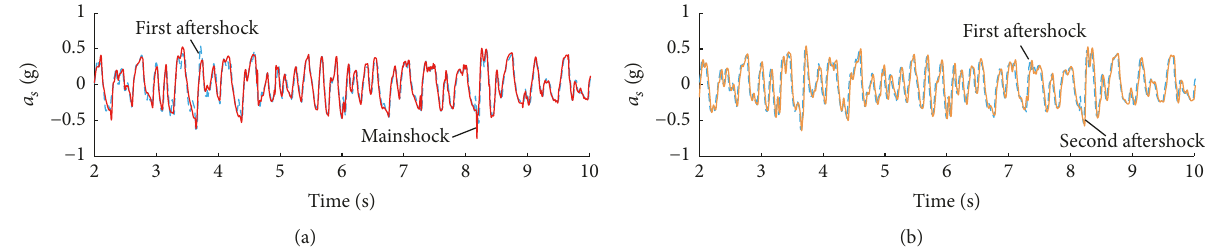
Figure 9: Effect of the earthquake sequence on the soil acceleration from beneath the footing.